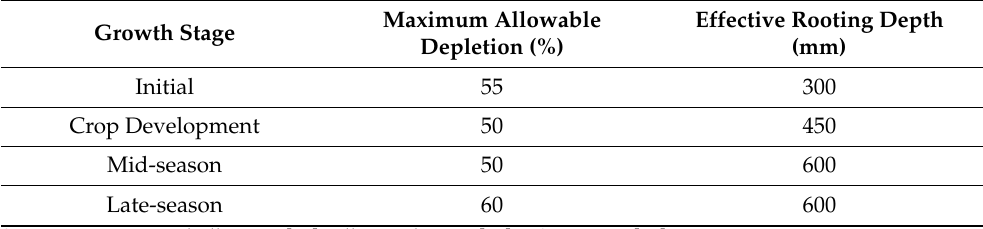
Maximum Allowable Depletion (%)